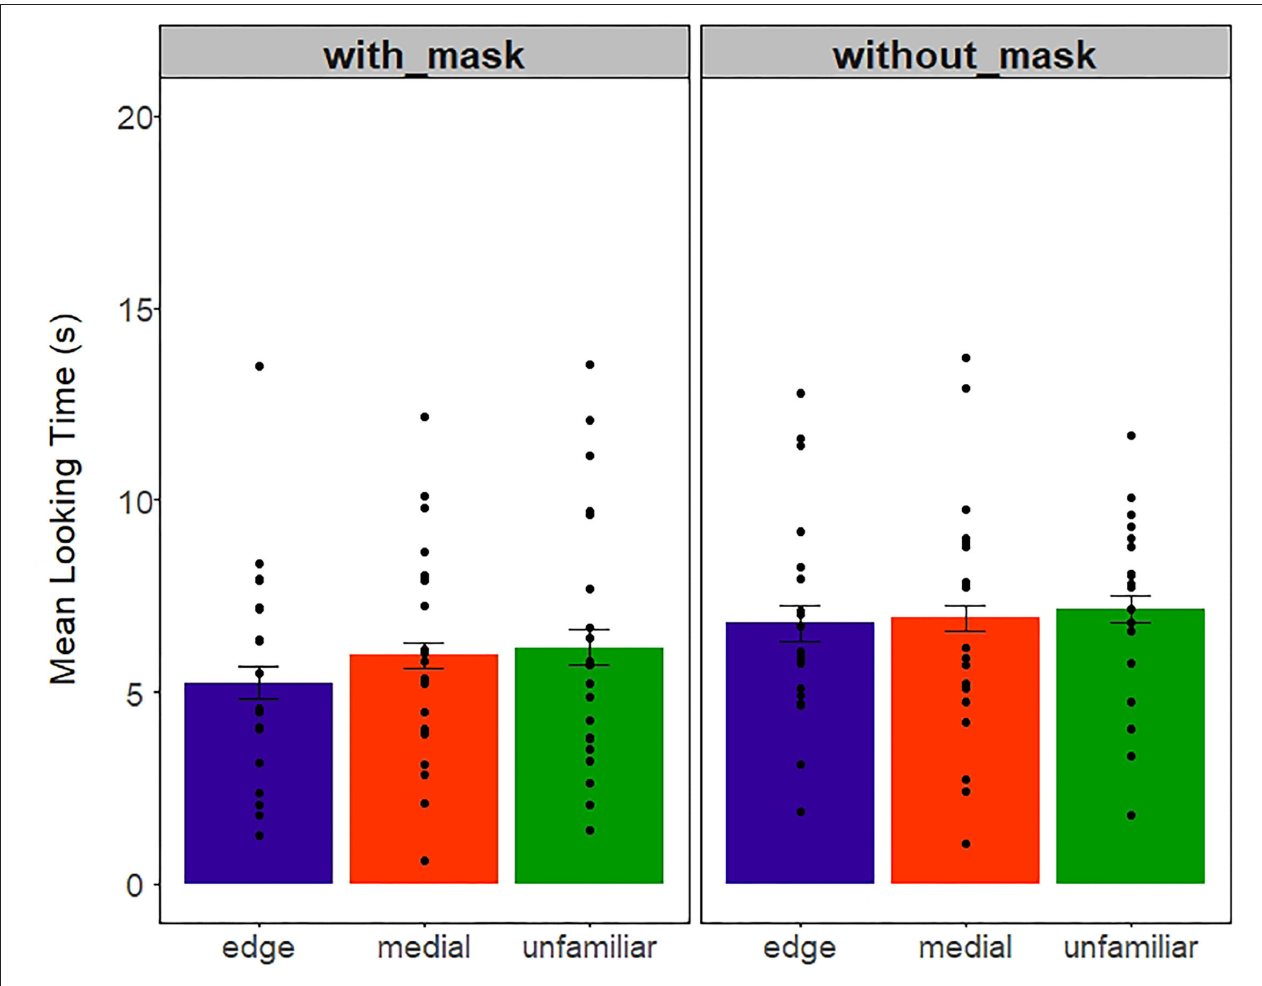
FIGURE 8 | Mean-looking time (s) in the Audiovisual experiment across mask and word-type conditions. Dots represent individual data points. Error bars represent 1 + /– standard error of mean.